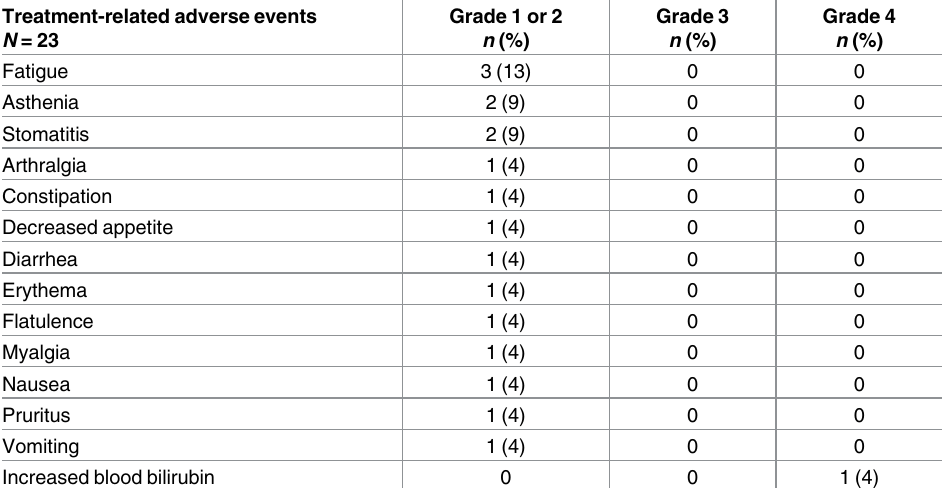
Table 2. Treatment-related